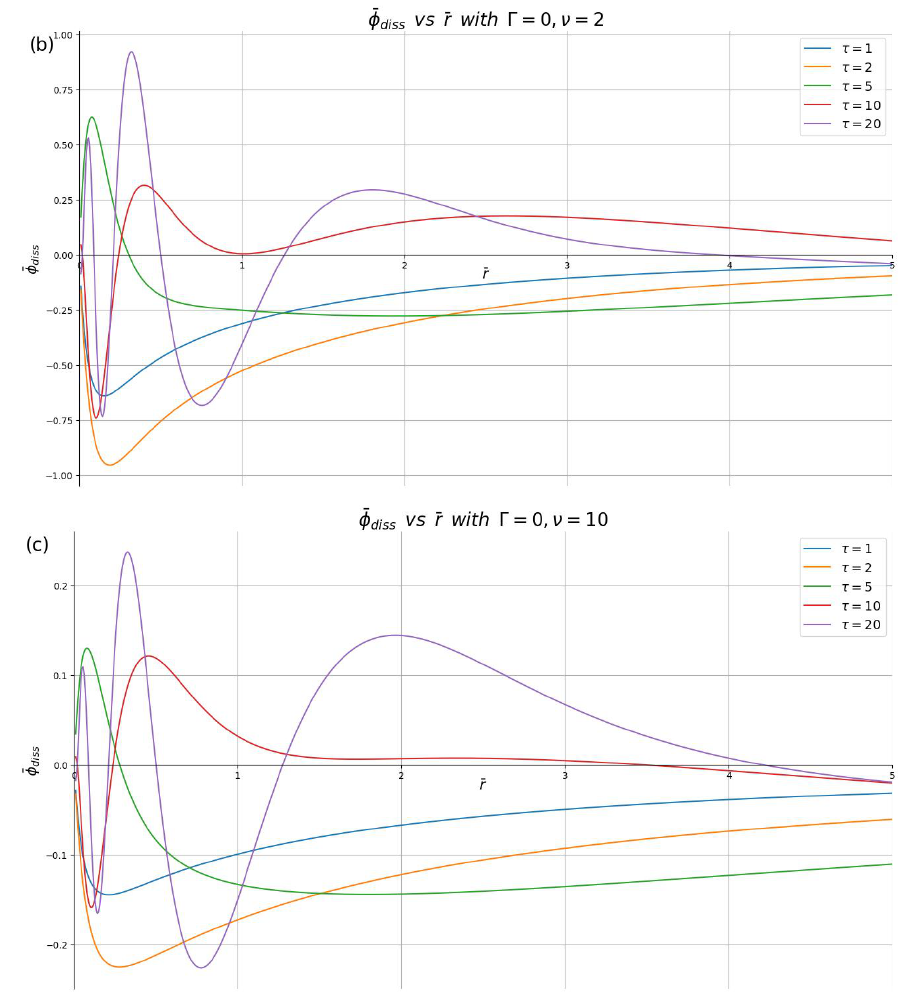
Figure 5. Dissipative part of the induced potential, ¯ φ diss in the plane z = 0, shown in reduced units against the dimensionless radial distance ¯ r for different dimensionless times ( τ = 1,2, 5,10,20), with the damping parameter Γ = 0 and the reduced speeds: ( a ) ν = 1, ( b ) ν = 2 and ( c ) ν =